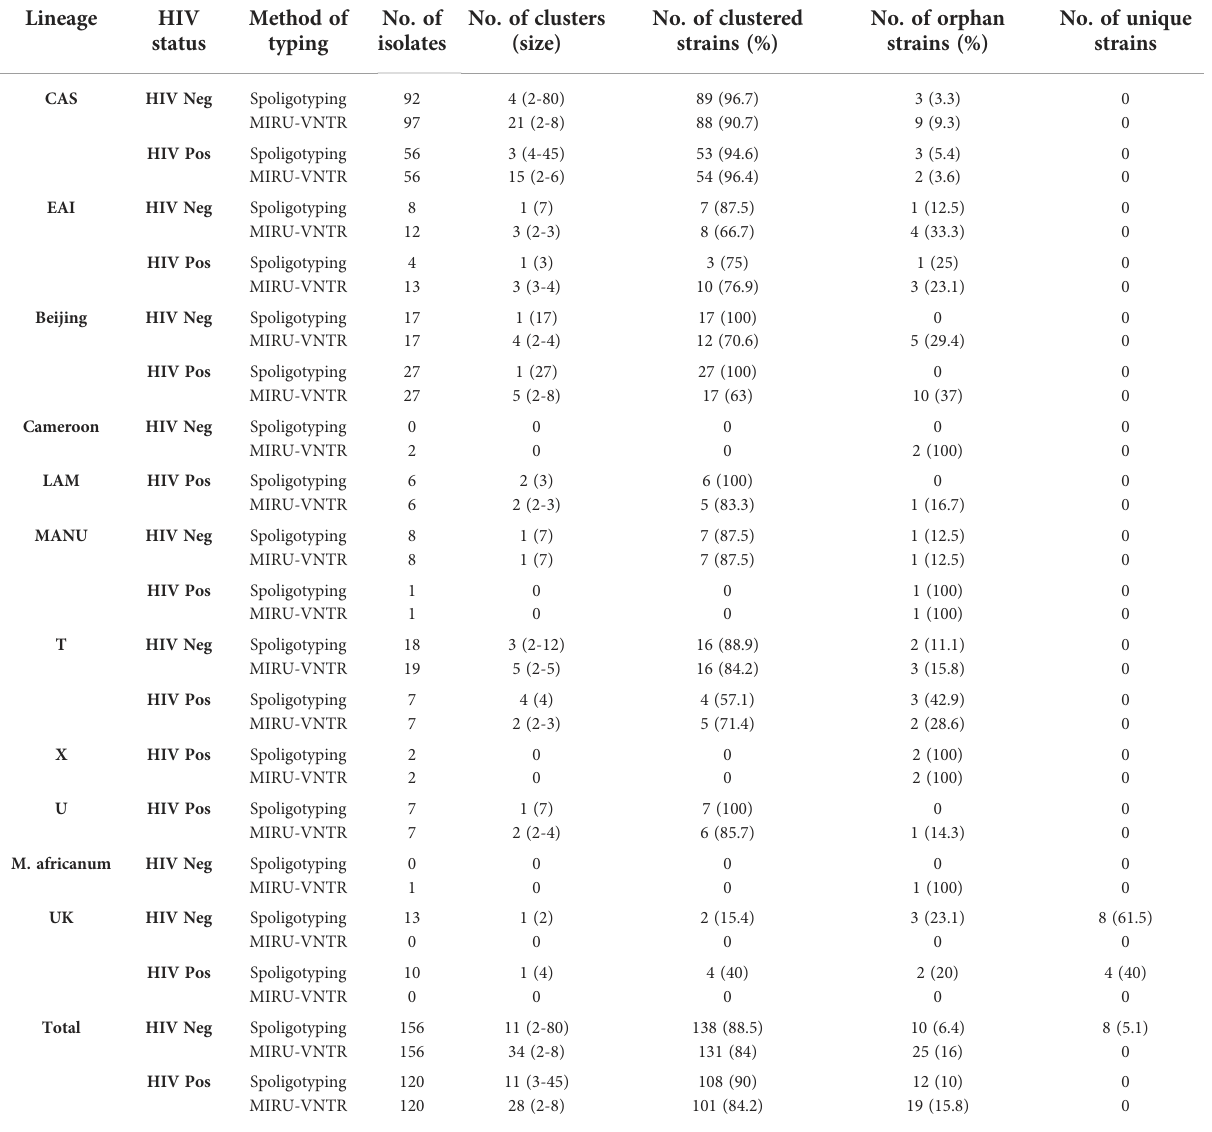
TABLE 4 Distribution and clustering patterns of various lineages of M. tuberculosis in HIV seronegative and HIV seropositive patients.